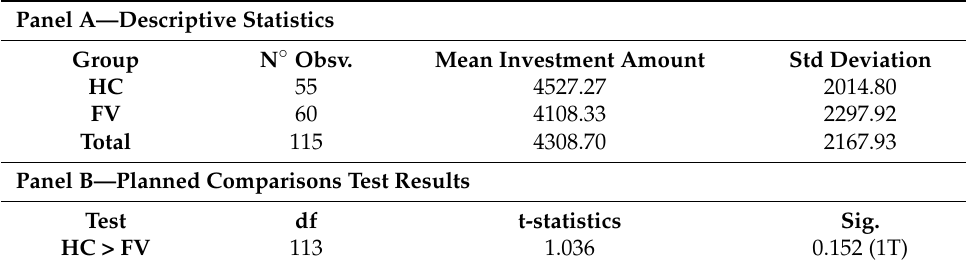
Table 1. Analysis of Investment Decisions. Panel A—Descriptive